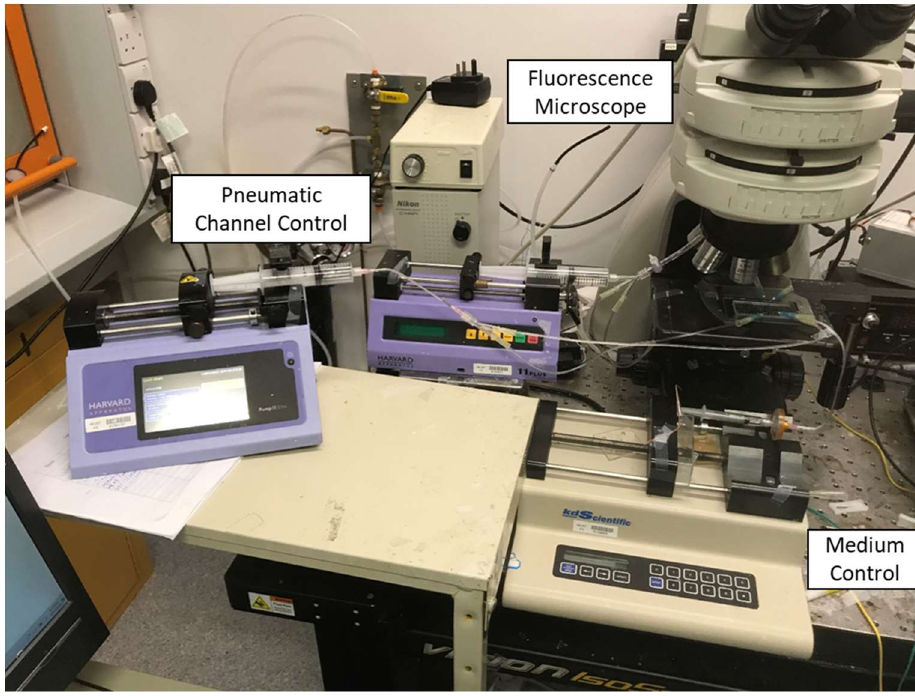
Figure 4. Experimental setup containing the syringe pumps to actuate the device.